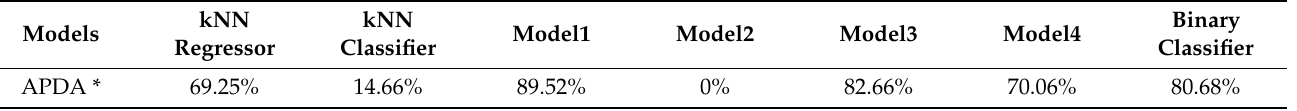
Table 2. Performance evaluation results of machine learning and deep learning